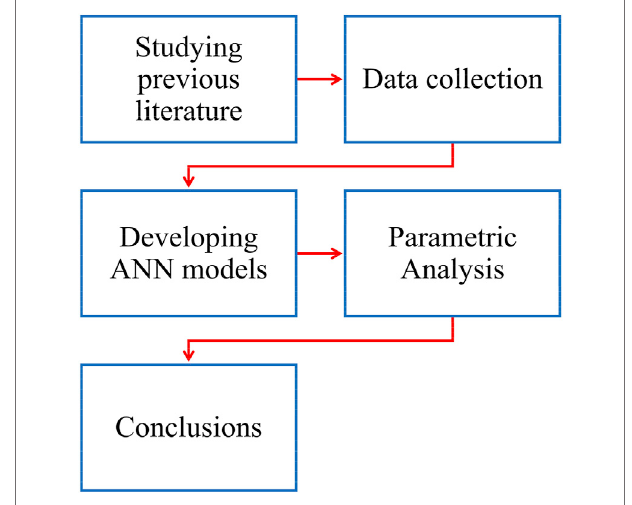
FIGURE 1 | Research program of this